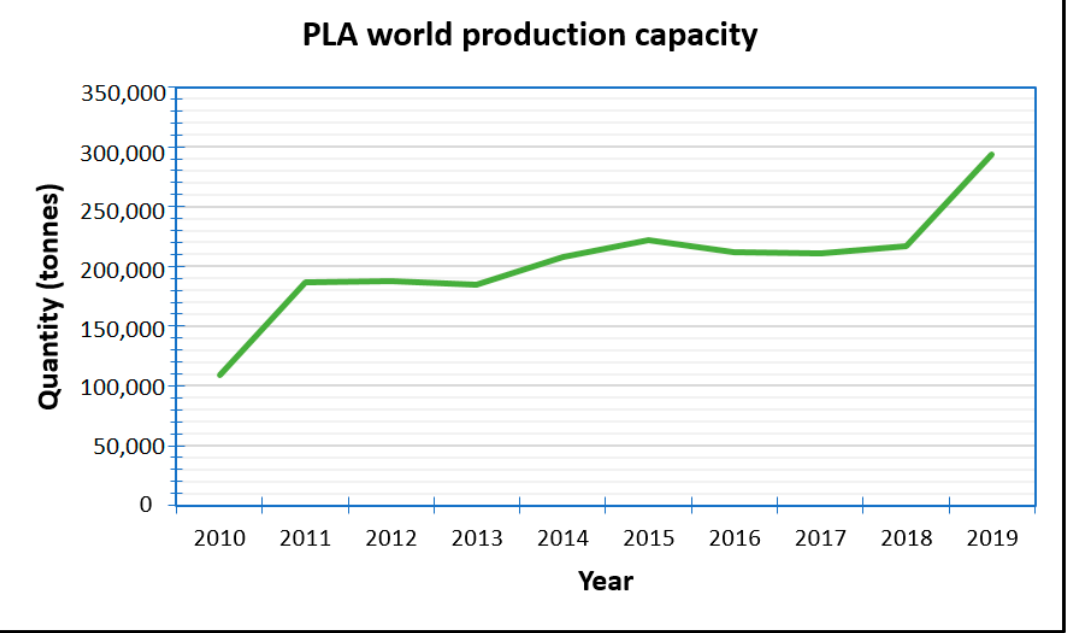
Figure 6. World production capacity for PLA (2010 to 2019). Data from [64].